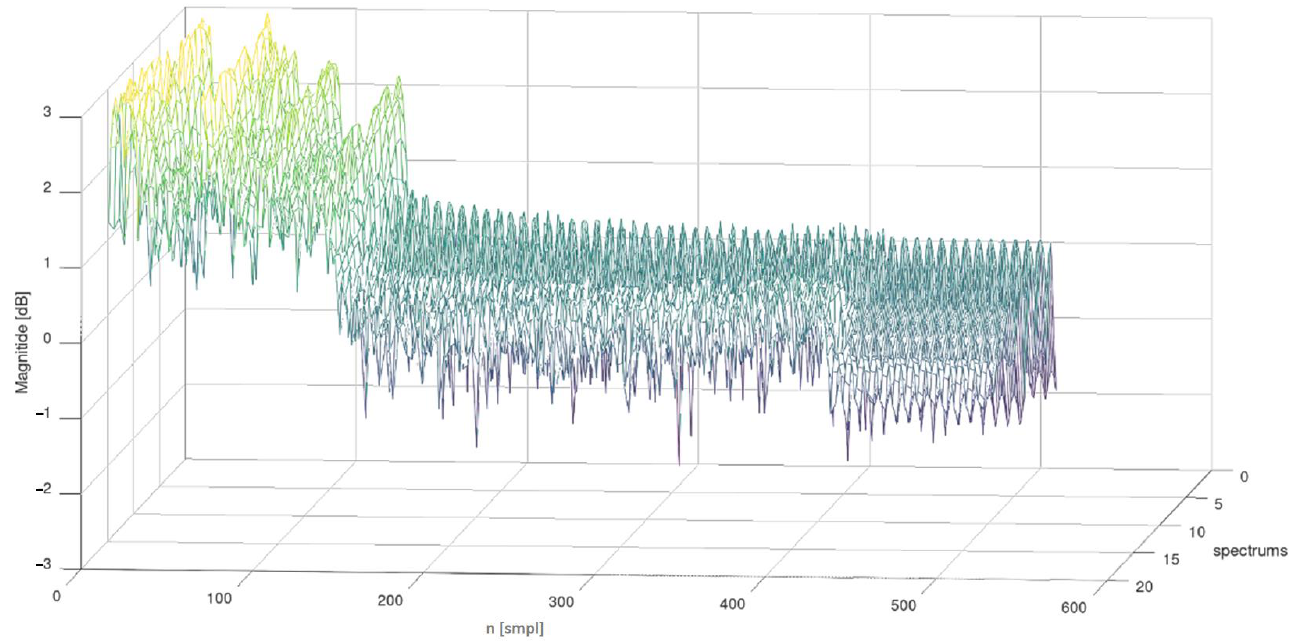
Figure 7. The matrix of spectra of the first phonetic segment of the word barrel (in Polish “beczka”, Seg 1 “be”)— spoken by a laryngectomised women.